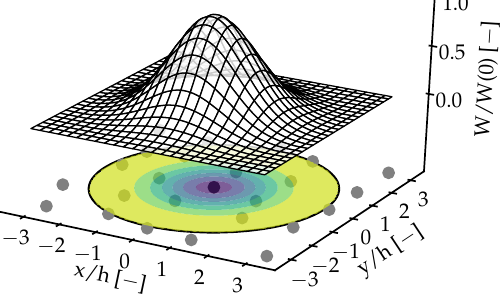
Figure 1. Top part: Surface of a 2-D kernel. Bottom part: Particle distribution superimposed with the kernel color map and illustration of the sphere of